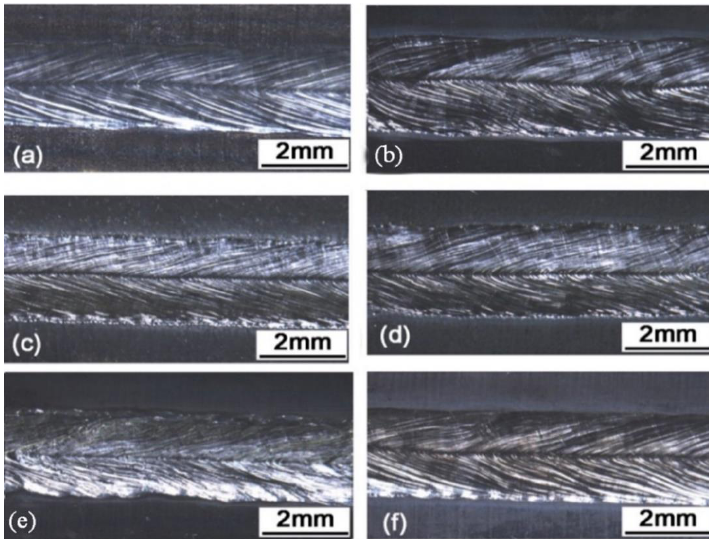
Figure 2. Effect of Rs on the weld appearances of the steel/Al joints produced by dual-beam laser welding with side-by-side configuration while the d 1 of 1.0 mm, the P L of 3000 W, the v of 33 mm/s, and the Δ Z of 0 mm were fixed: ( a ) 0.25; ( b ) 0.50; ( c ) 0.67; ( d ) 1.50; ( e ) 2.00; ( f ) 4.00.